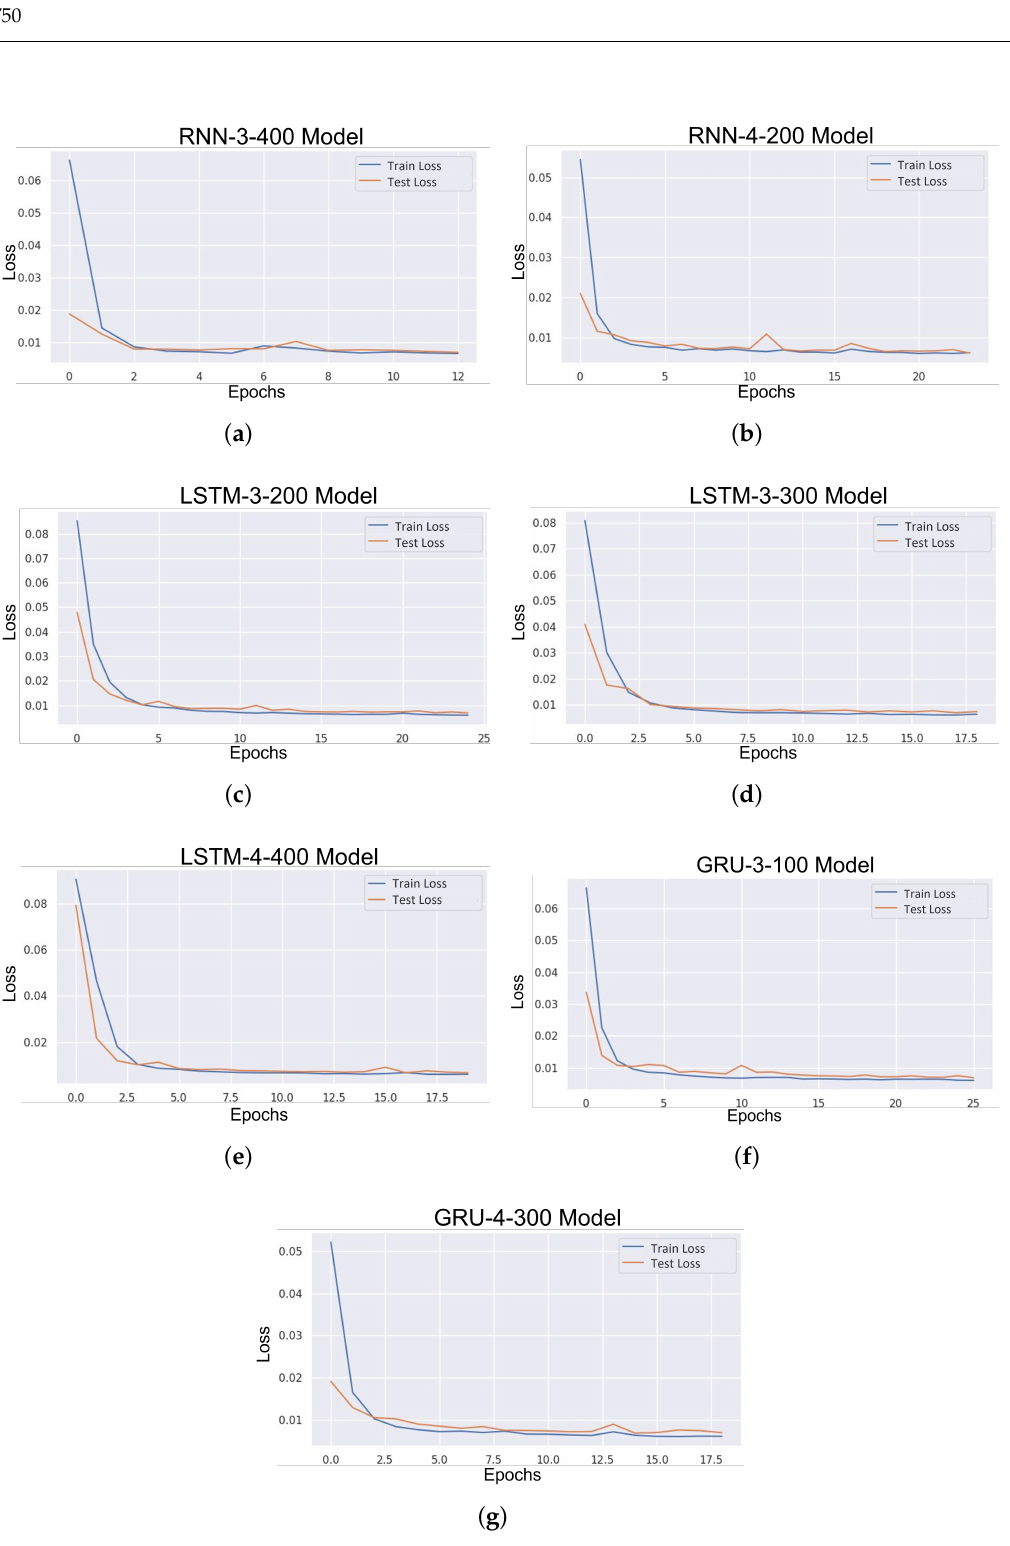
Figure 7. Convergence results for the ( a ) Recurrent Neural Network (RNN)-3-400; ( b ) RNN-4-200; ( c ) Long Short-Term Memory (LSTM)-3-200; ( d ) LSTM-3-300; ( e ) LSTM-4-400; ( f ) Gated Recurrent Unit (GRU)-3-100; and ( g )